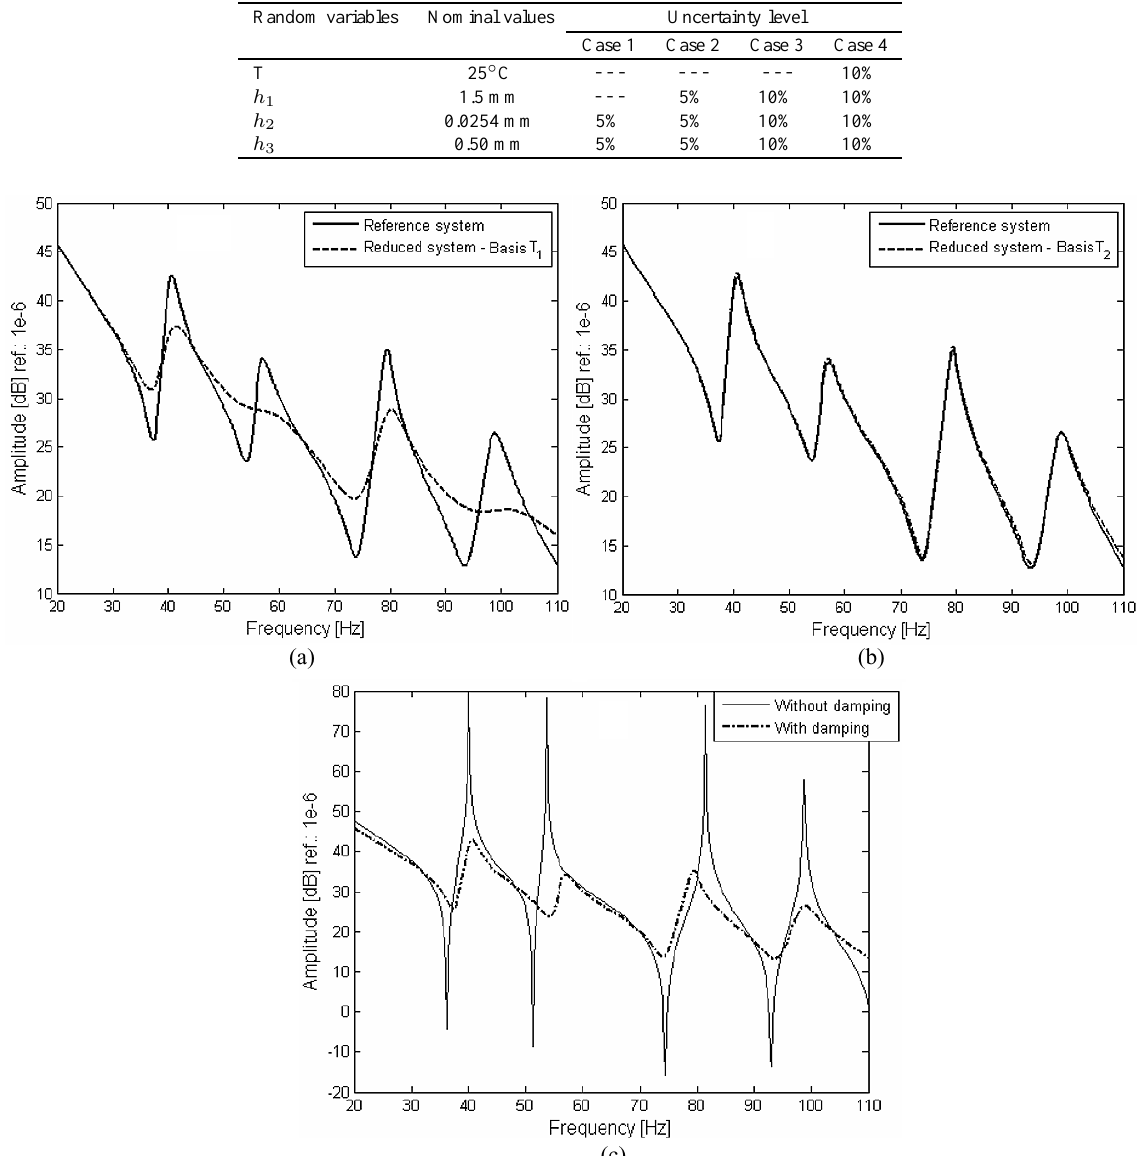
Fig. 5. FRF amplitudes of the reference and reduced systems by using reduction bases. (a) T 1 and (b) T 2 . (c) FRF amplitudes obtained for the plate with and without PCLD.